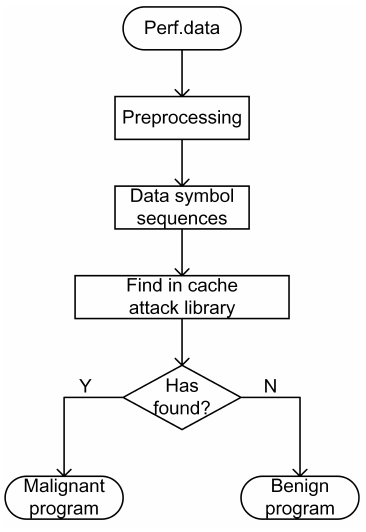
Figure 3. Detector execution